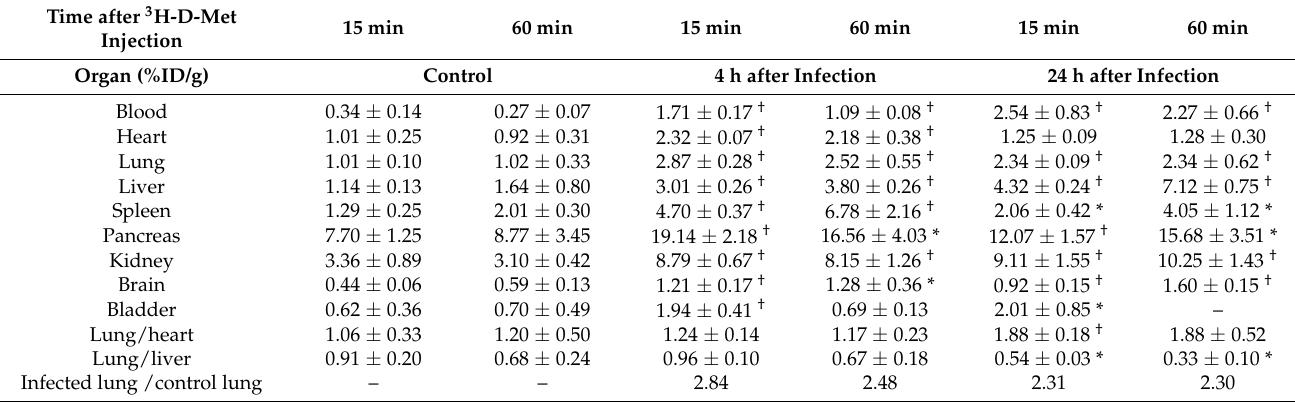
Table 2. Biological distribution of 3 H-D-Met in lung-infection-model